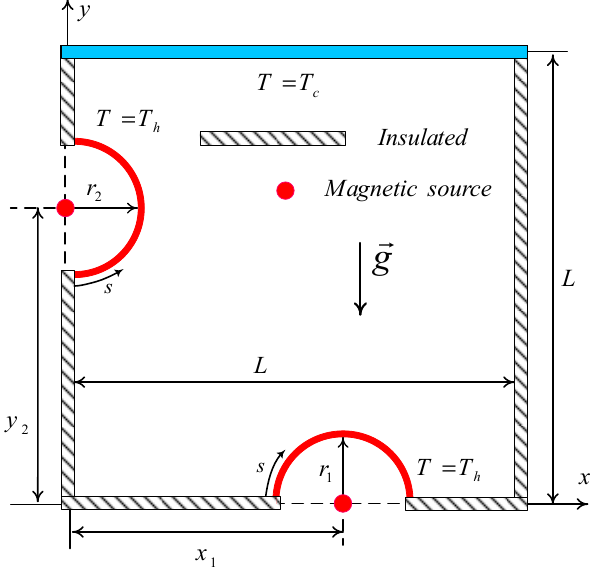
Figure 1. Configuration of the computational domain.